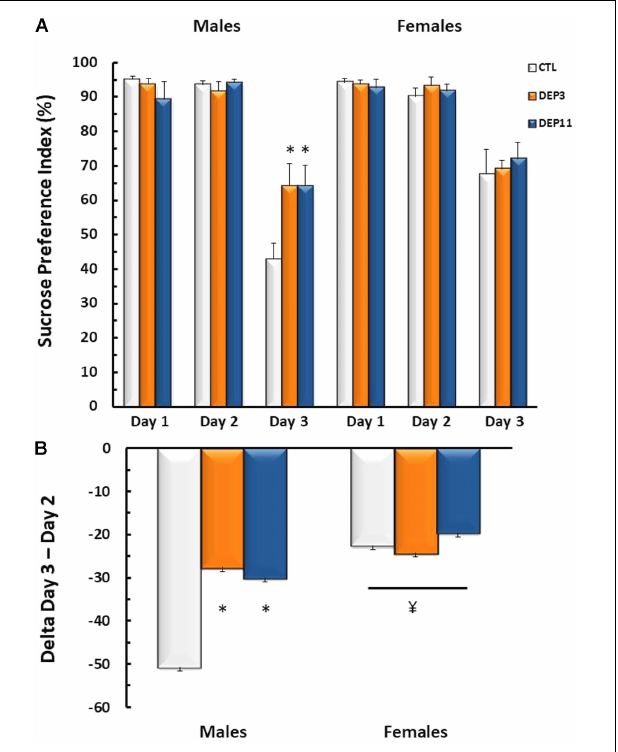
FIGURE 2 | (A) Sucrose preference index and (B) variation of sucrose intake between Days 3 (2.1% sucrose concentration) and 2 (15% sucrose concentration) in the sucrose negative contrast test. Animals were maintained with their mothers (CTL), deprived on postnatal day (PND) 3 (DEP3) or on PND 11 (DEP11) and tested between PNDs 52 and 60. Data are presented as mean ± SEM of 10–11 animals/group/sex. ∗ – Different from CTL group; (cid:85) – different from respective male